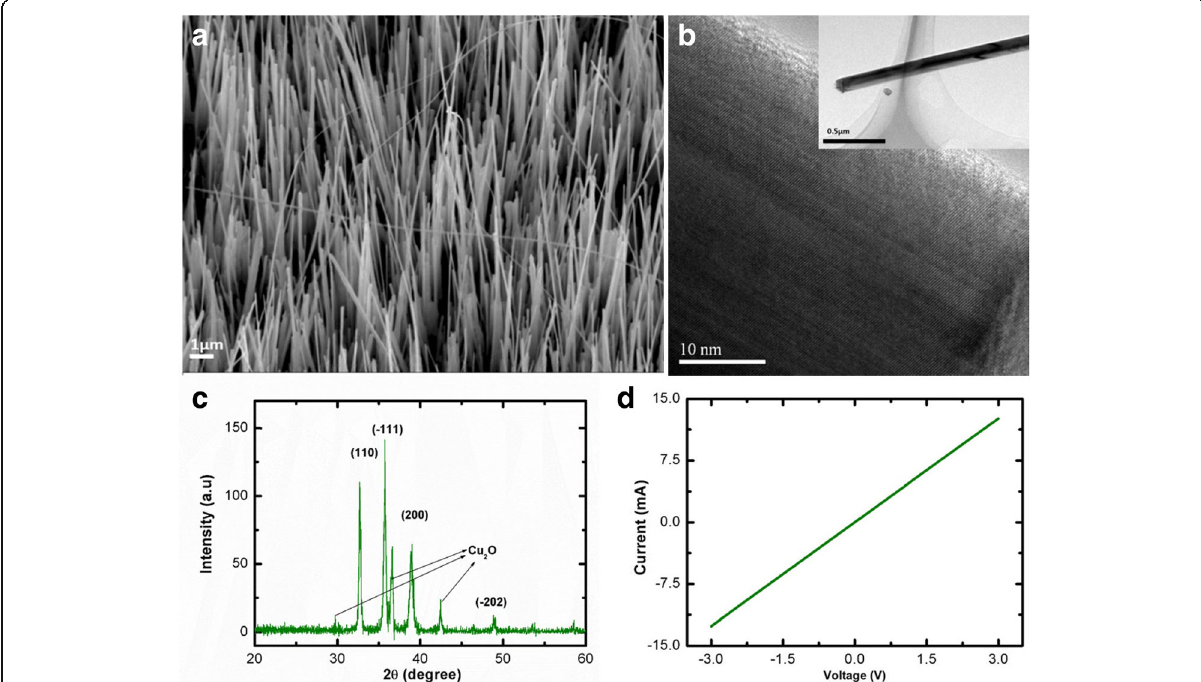
Fig. 1 a FESEM image of the grown CuO NWs. b TEM image of CuO. c X-ray diffraction profile of CuO nanowires. d IV characteristics of CuO and